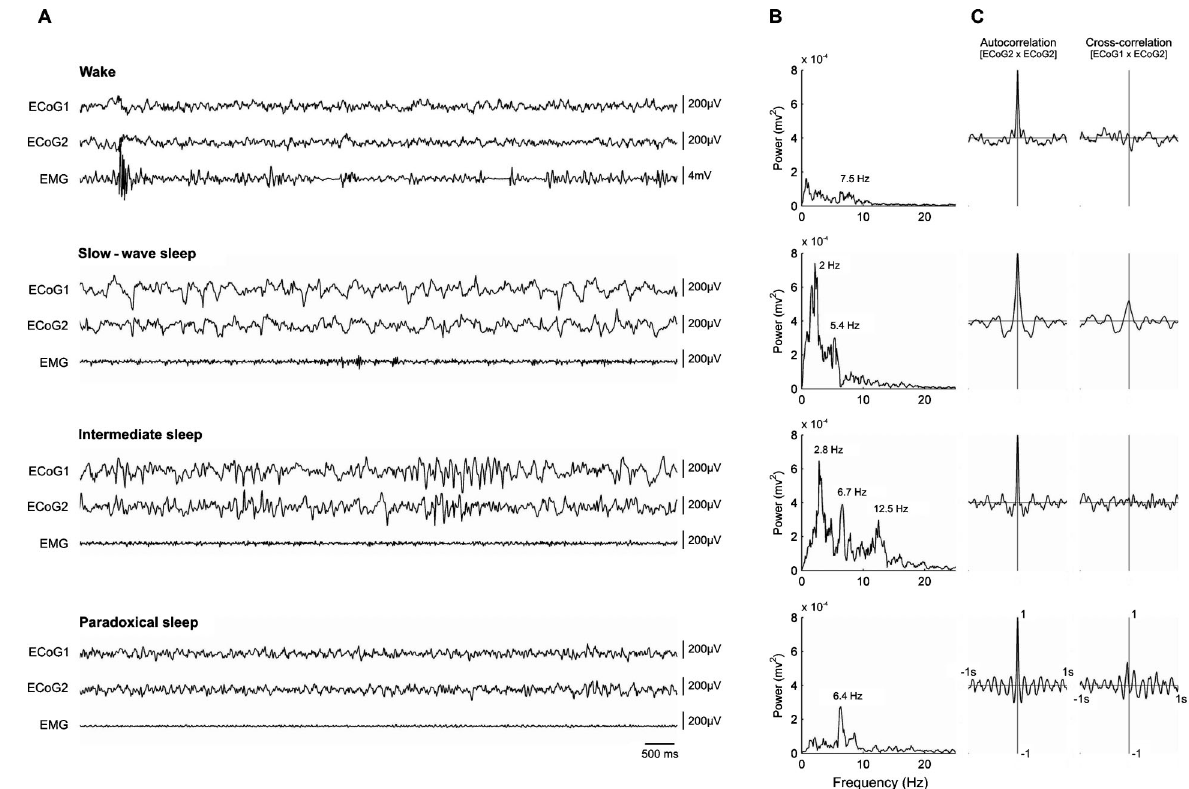
Figure 1. A , Representative traces of the four (wake, slow-wave sleep, intermediate sleep, and paradoxical sleep) identified electrocorticograms (ECoG1 and ECoG2) and electromyogram (EMG) patterns used to score the sleep-wake cycle. B , Fast Fourier transformation of the ECoG2 trace showing the peak frequencies in each state. C , Auto- (left column) and cross-correlations (right column) of the ECoG